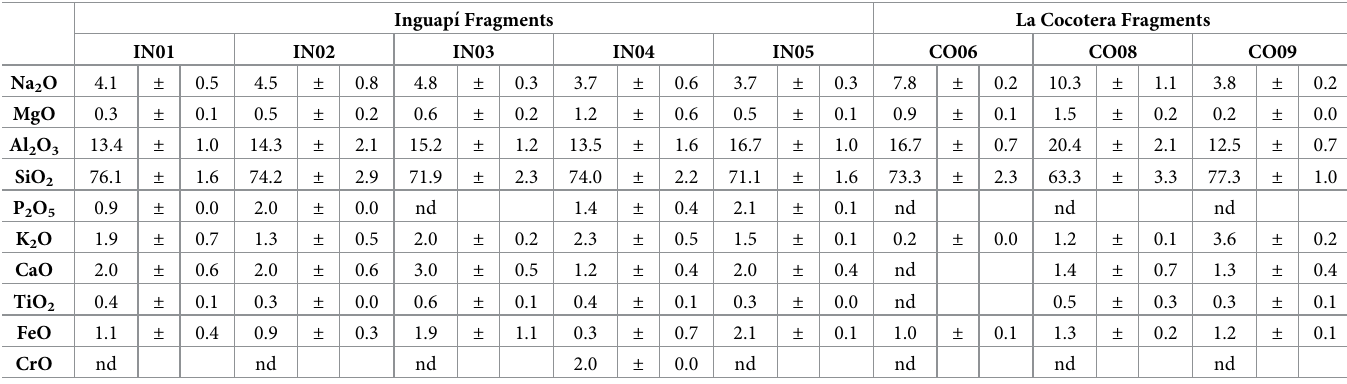
Table 7. Results of the chemical composition obtained by SEM-EDS of volcanic glasses presented as stoichiometric percentages by weight compound. Inguapı´Fragments La Cocotera Fragments IN01 IN02 IN03 IN04